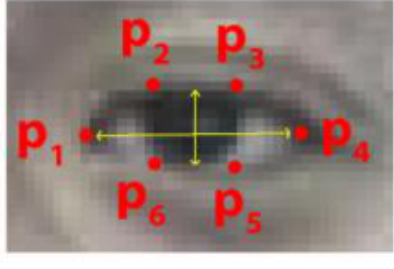
Fig. 5. Landmarks for an opened and closed